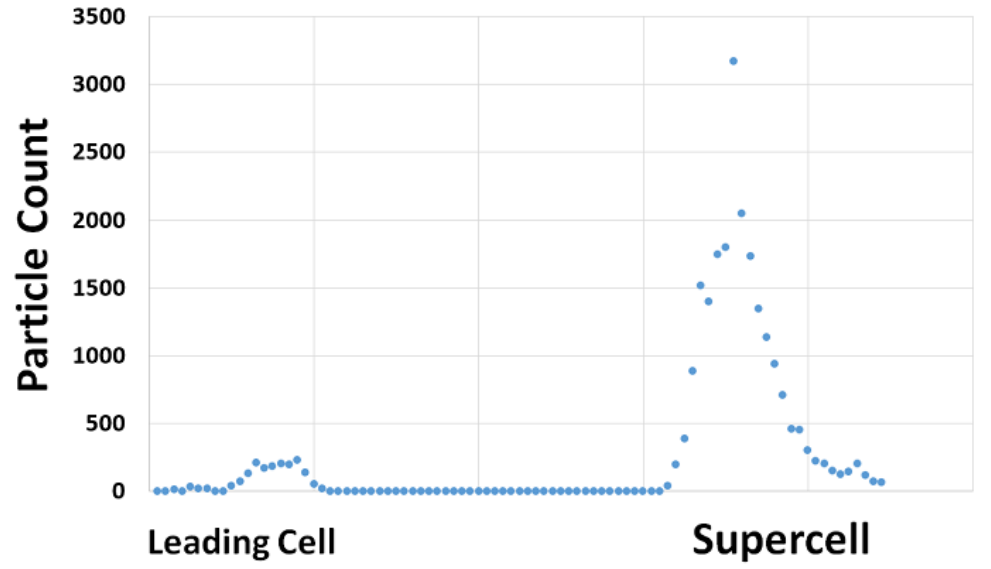
Figure 6. Total number of precipitation particles detected per minute by the disdrometer after quality control was applied.